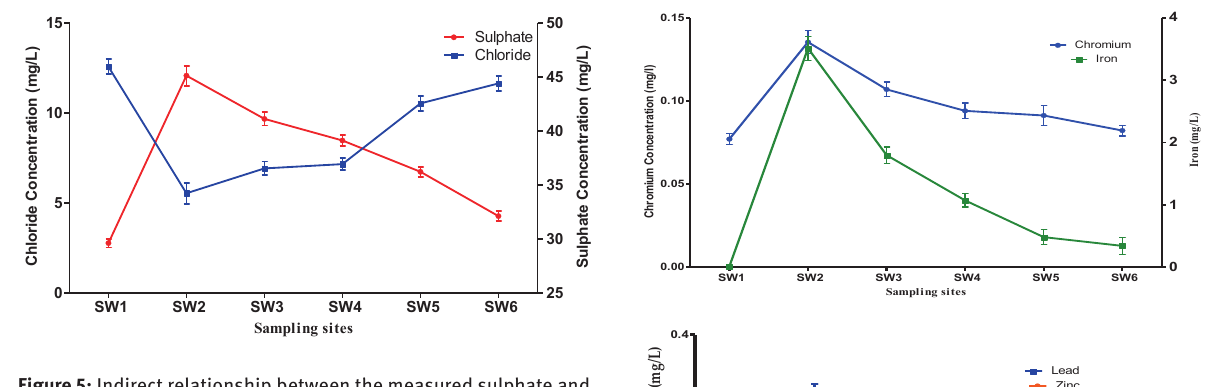
Figure 5 Figure 5: Indirect relationship between the measured sulphate and chloride concentrations in the surface water and leachate samples collected from Ndawuse River and dumpsite.